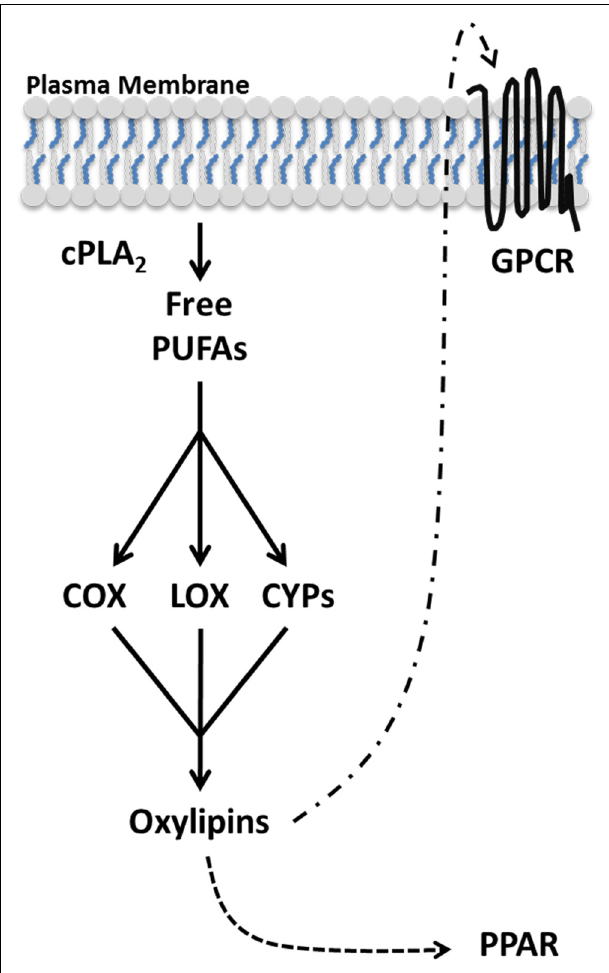
FIGURE 1 | Oxylipin biosynthesis and signaling. Oxylipins are synthesized de novo from polyunsaturated fatty acids (PUFAs) in an activation dependent manner. Upon cellular activation, cPLA 2 hydrolyzes PUFAs from the lipid membrane generating free PUFAs. Oxygenases (COX, LOX, and CYP) metabolize free PUFAs into distinct oxylipins. Oxylipins can diffuse through the plasma membrane and bind GPCRs in the local environment. Additionally, select oxylipins can activate the transcription factor PPAR.